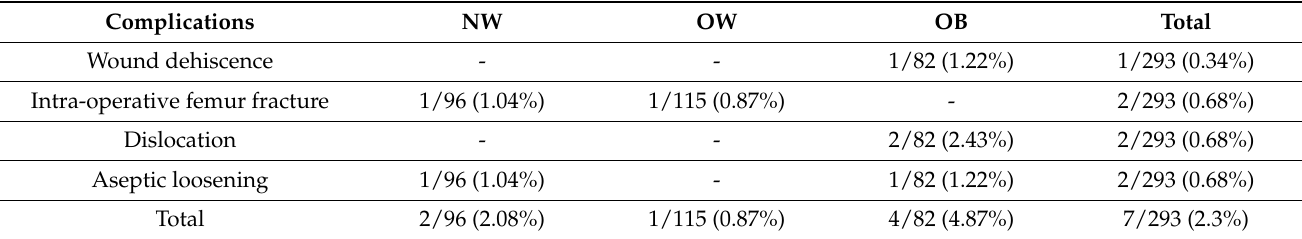
Table 2. Complications that occurred in the study